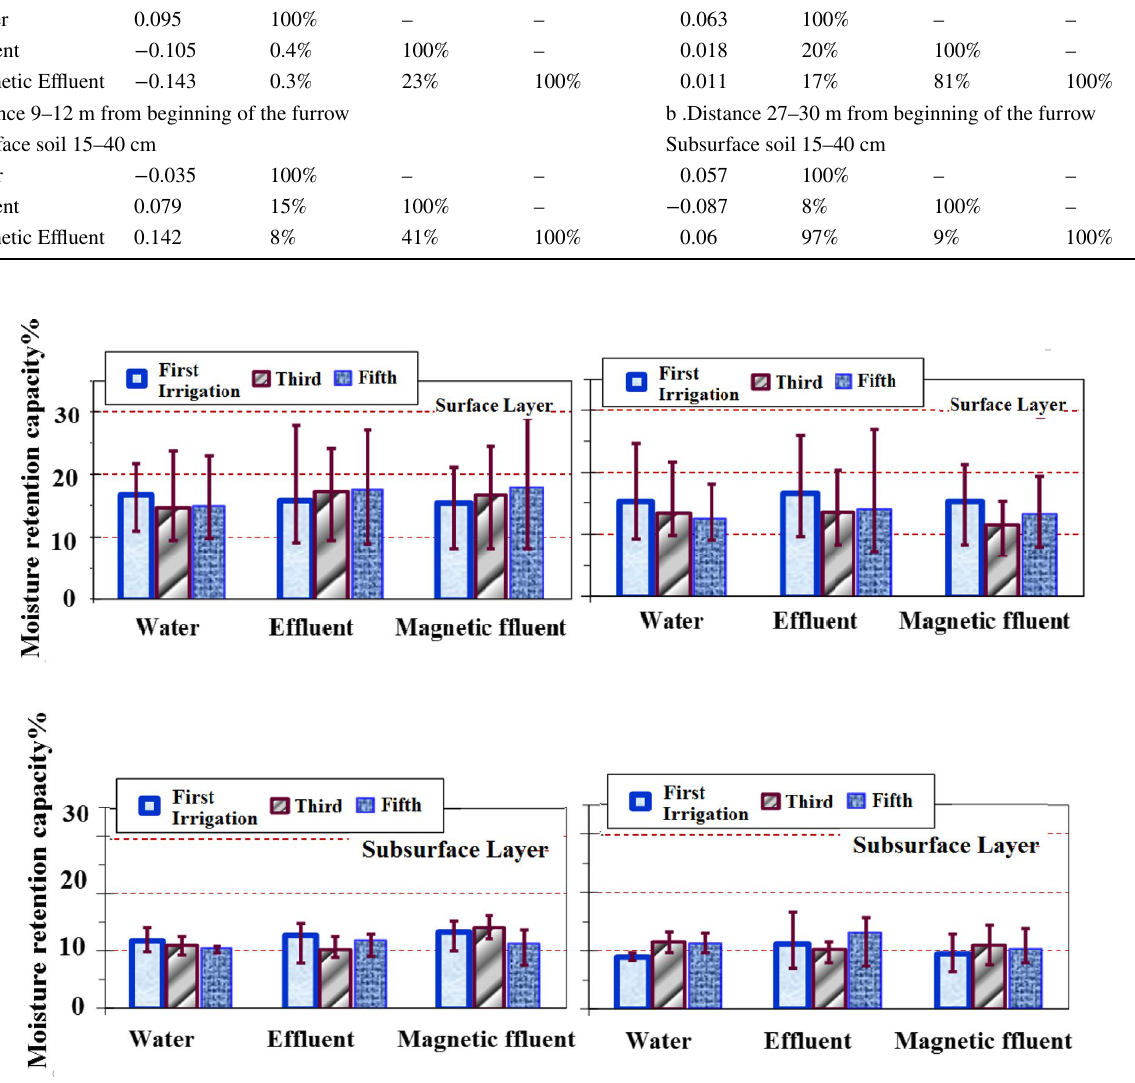
Fig. 2 Soil holding capacity during the irrigation period, at the beginning (left) and the end of the furrow